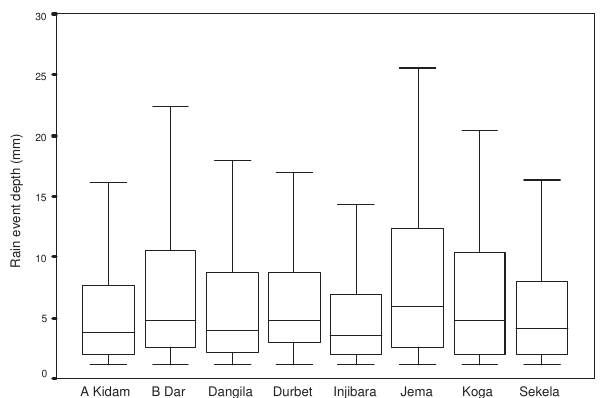
Fig. 2. Box-whisker plot of the rain event depths in JJA of 2007 as Fig. 2 Box-whisker plot of the rain event depths in JJA of 2007 as observed at eight 735 observed at eight rain gauge stations. The lower and the upper bars rain gauge stations. The lower and the upper bars indicate the 25 % quartile minus 736 indicate the 25% quartile minus 1.5 IQR and the 75% quartile plus 1.5 IQR and the 75 % quartile plus 1.5 IQR, respectively. IQR refers to the 737 interquartile range which is defined by the height of the box. The bar inside the boxes 738 1.5 IQR, respectively. IQR refers to the interquartile range which shows the median while the upper and lower edges of the boxes show the 75 % and 739 is defined by the height of the box. The bar inside the boxes shows the 25 % quartiles. 740 the median while the upper and lower edges of the boxes show the 741 75% and the 25%